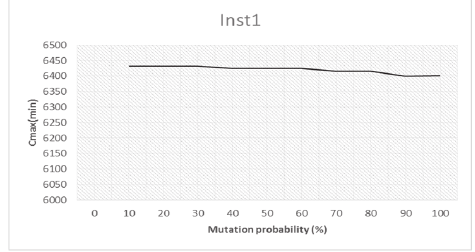
Fig. 5 . Crossover influence on the objective function Fig. 6. Mutation influence on the objective